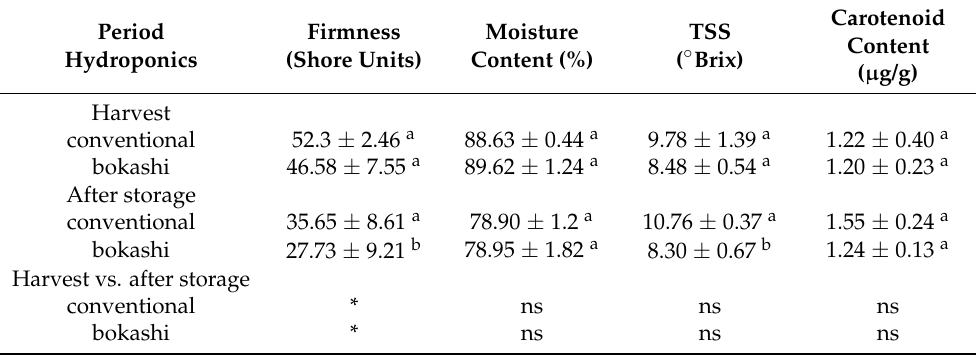
Table 6. The effects of conventional and bokashi hydroponics on respiration rate, firmness, moisture content, total soluble solids (TSS) and carotenoids in bell peppers at harvest and after storage for 14 days at 7 ◦ C and 95%